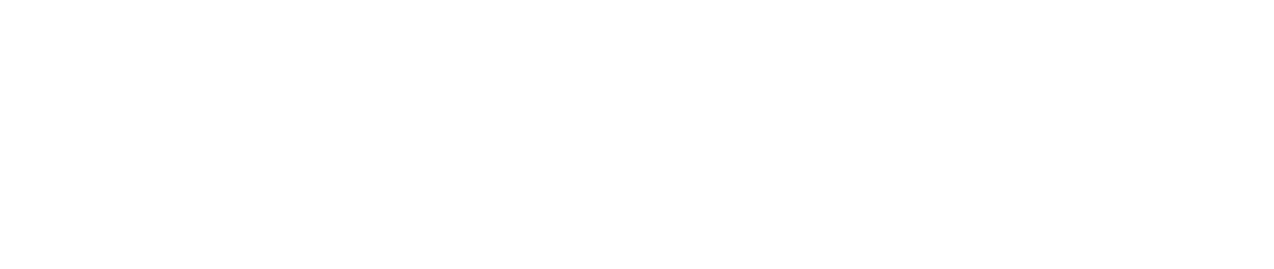
Frontiers in Psychology |